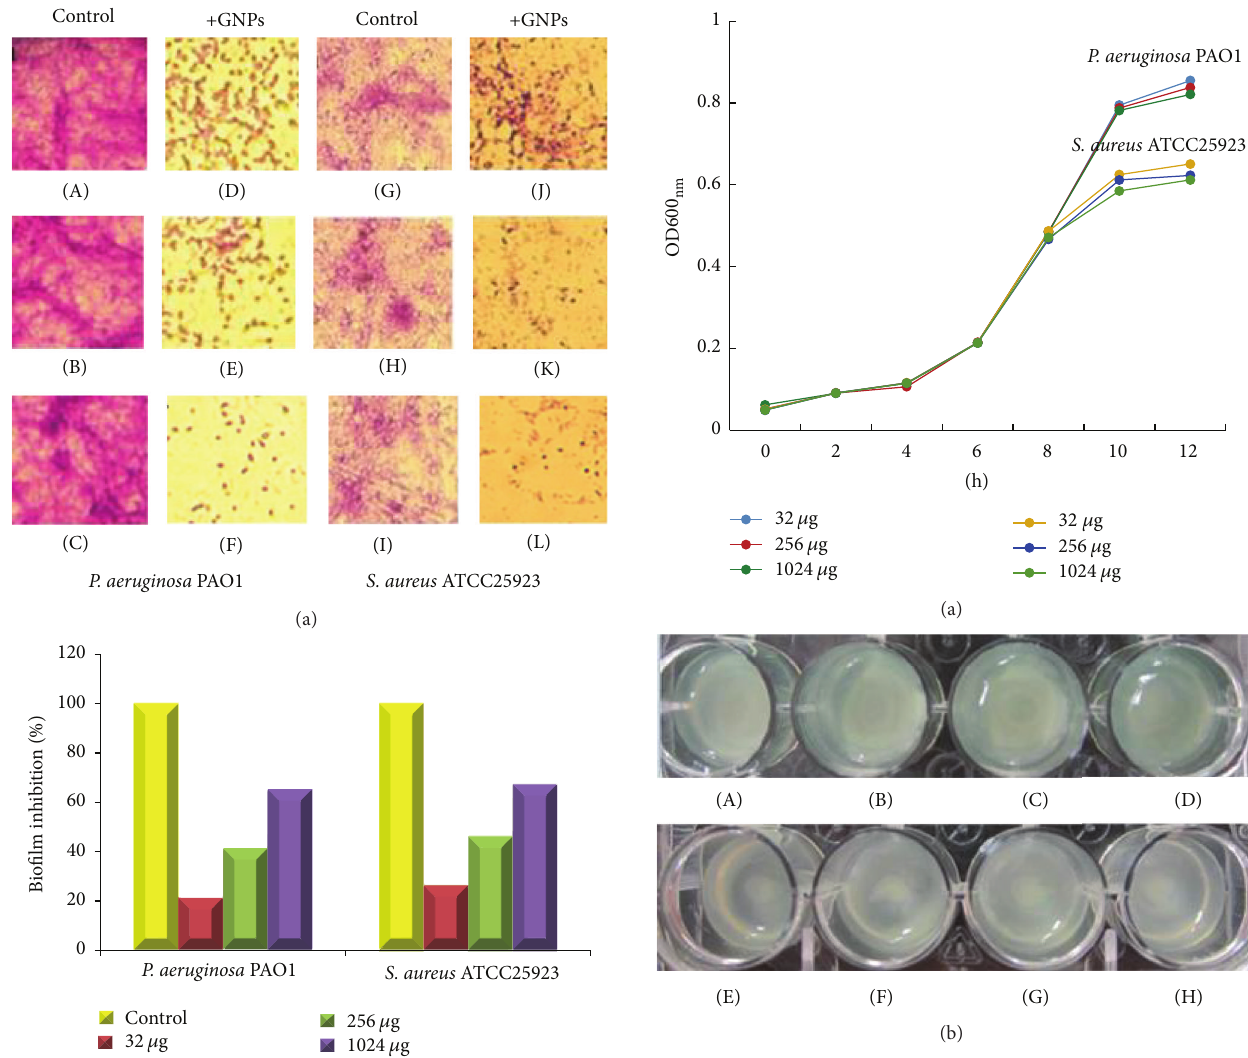
Figure 6: Growth profiles of the bacterial strains in 12h (a). Com- parison of cell growth in the presence of different concentrations of GNPs at 12h (b). The upper and lower graphs represent cell growth of P. aeruginosa PAO1 and S. aureus ATCC25923, respectively. The graphs (A) and (E) are positive controls by erythromycin; (B) and (F), (C) and (G), and (D) and (H) represent the presence of 32, 256, and 2024 𝜇 g of GNPs,